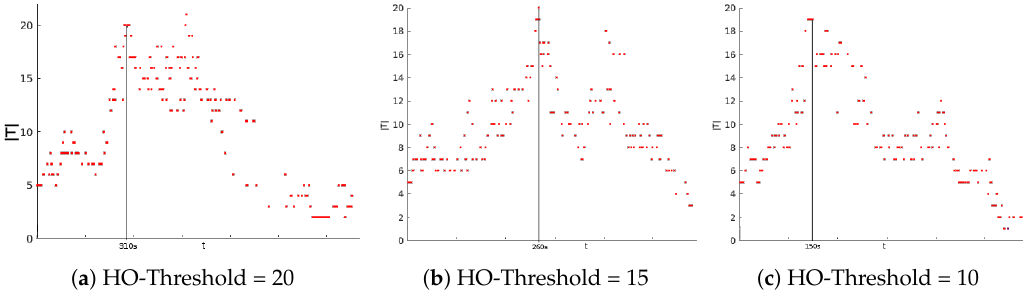
over time for different instances of the AAMO approach T u | | and the end of the dispersion stage are reached at the same T u | | considered by robots (on average) along the T u | |